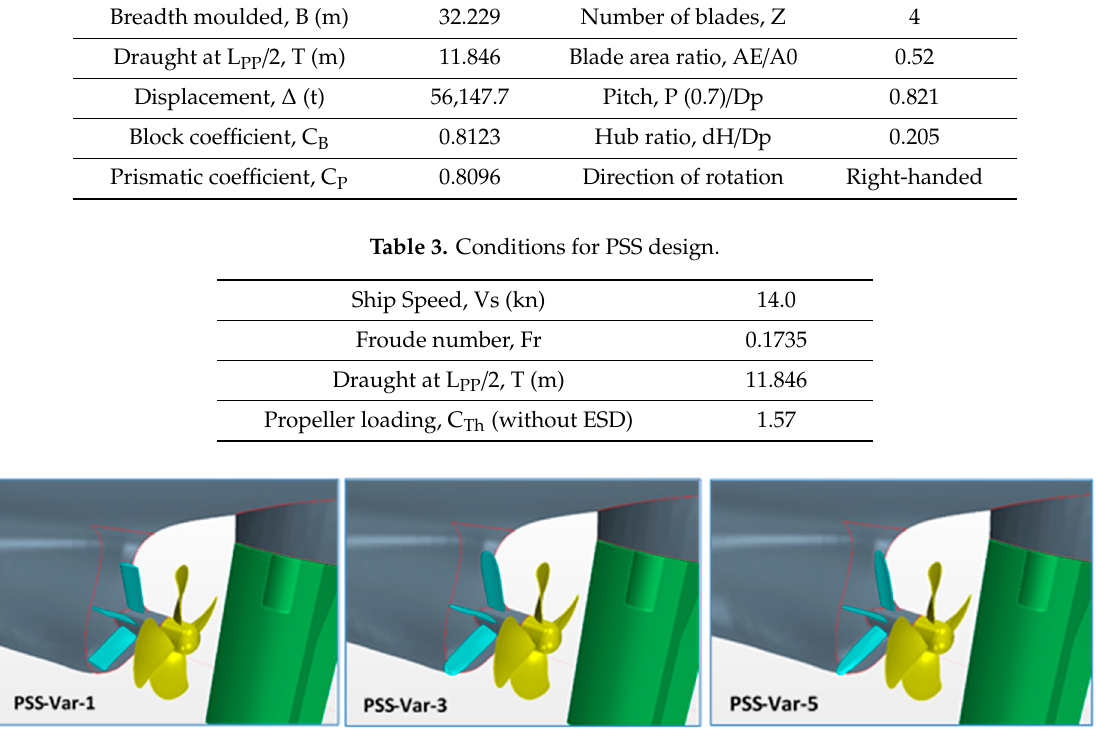
Figure 7. Evolution of PSS design in the process of design exploration. Table 4. Conditions for PSS